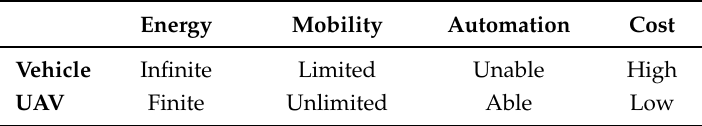
Table 2. Comparison of mobile